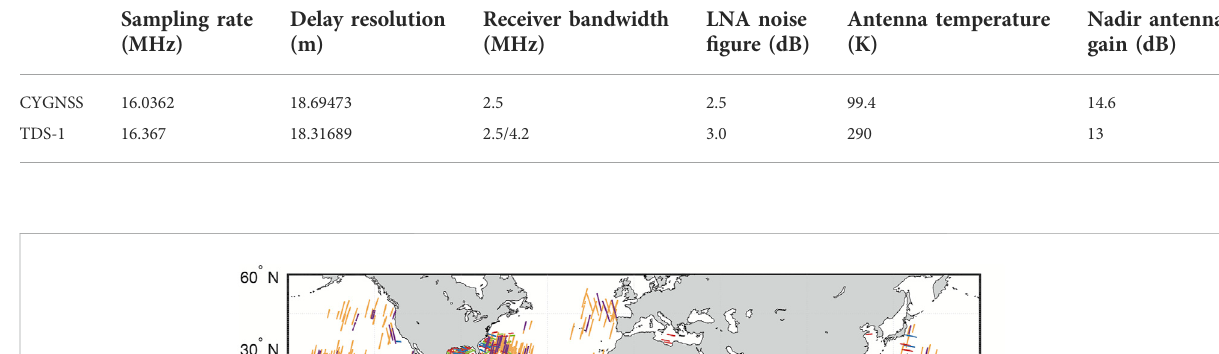
TABLE 1 Con fi guration of RF front-end onboard CYGNSS/TDS-1.